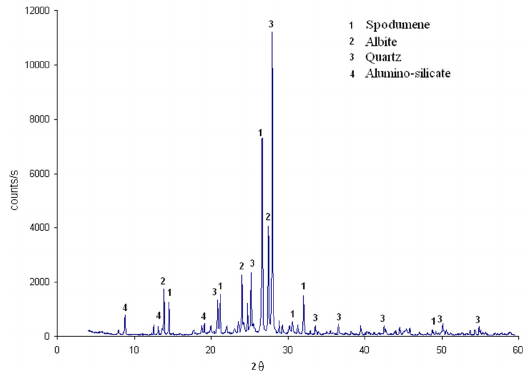
Figure 1. XRD pattern of spodumene-bearing rock.